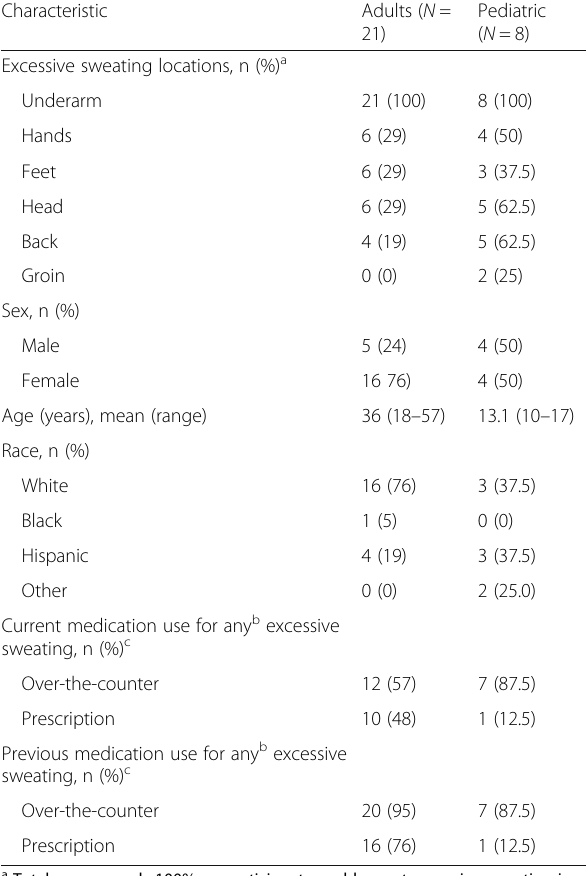
Table 2 Characteristics of Interviewees Reported at Screening